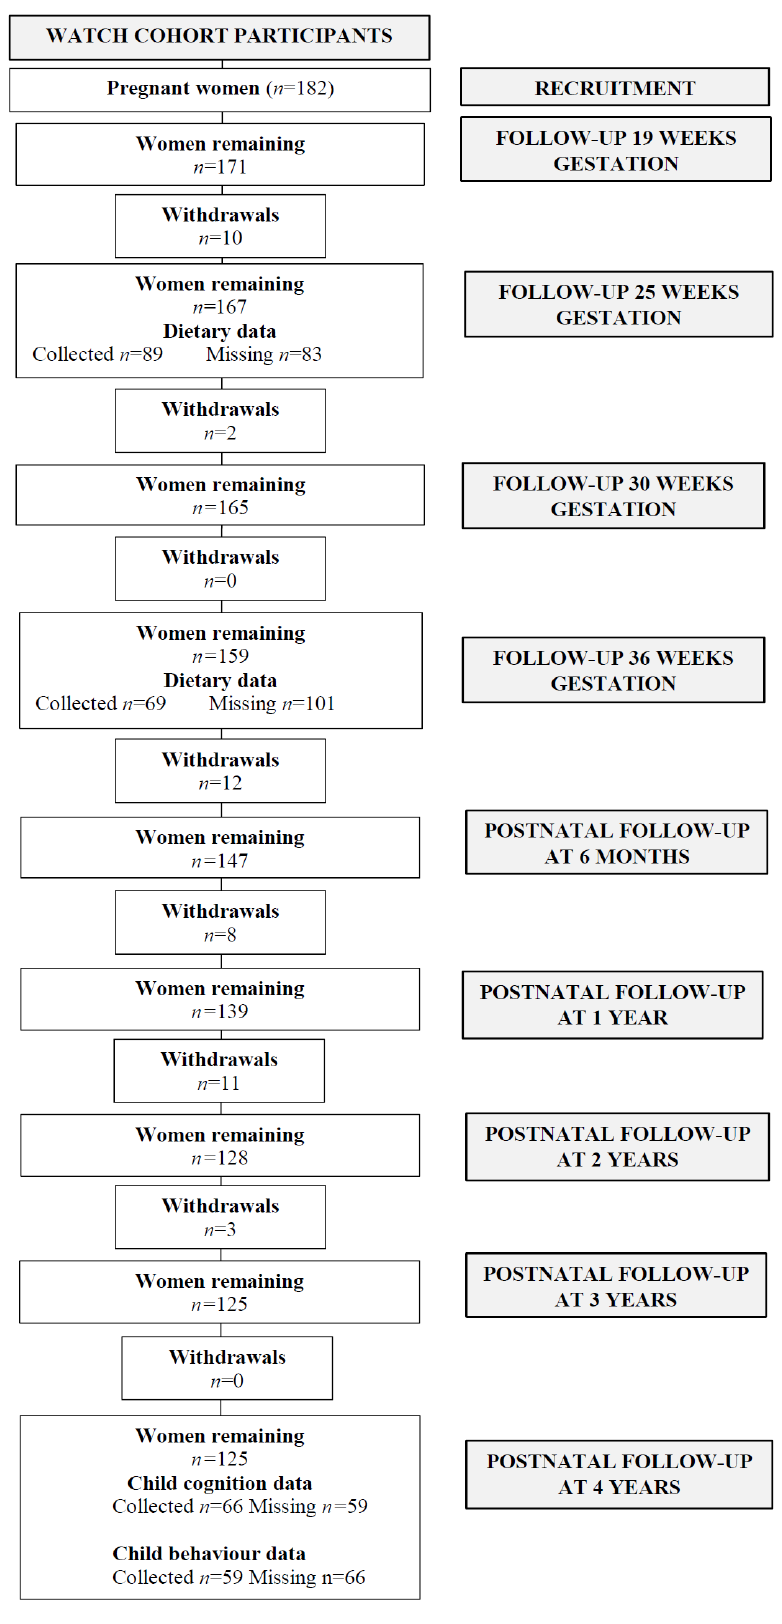
Figure 1. Flowchart of mother–child pairs enrolled in the WATCH cohort and included in the statistical